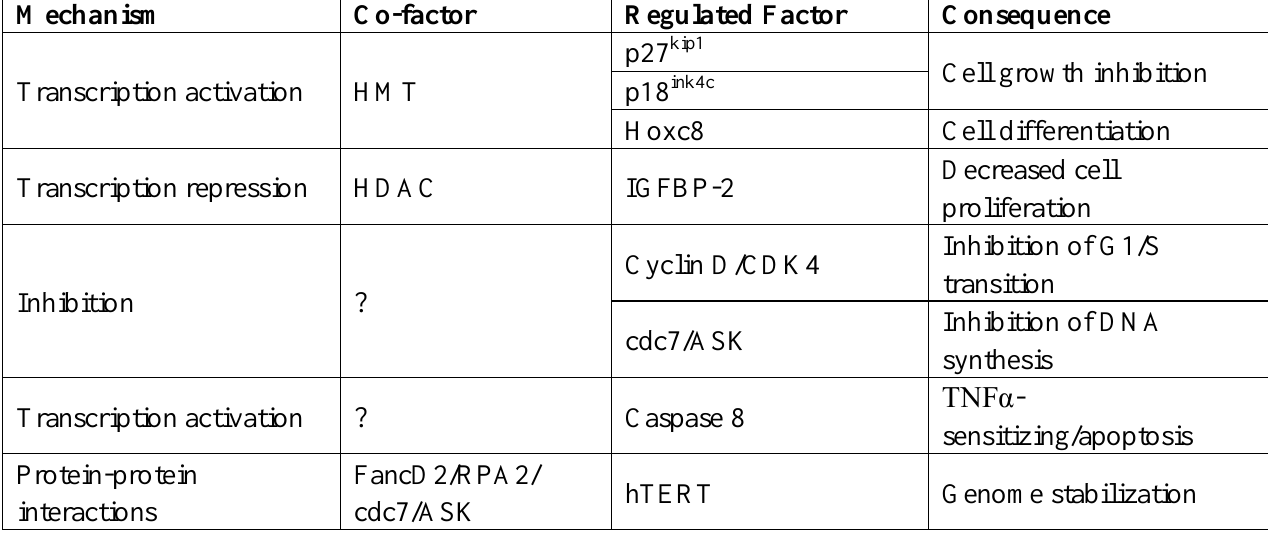
Table 1. Mechanisms of menin tumor suppression (according to